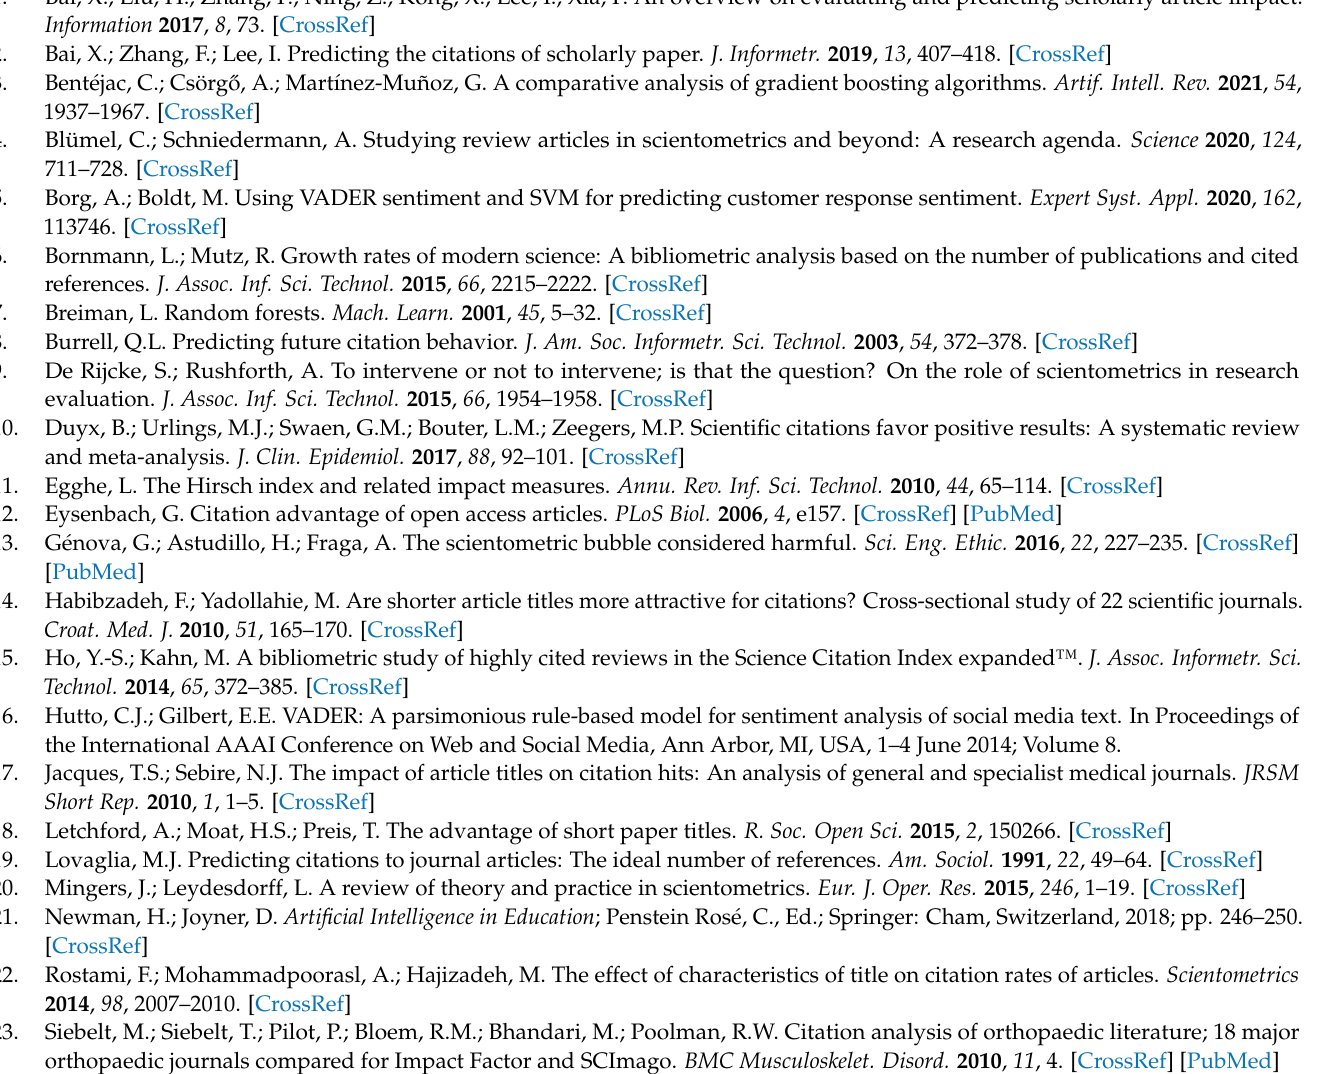
Figure A4. Confusion matrix for Gradient Boosting. The matrix breaks down articles that were predicted to have a low or high citation count and what they were actually like (‘Observed’).